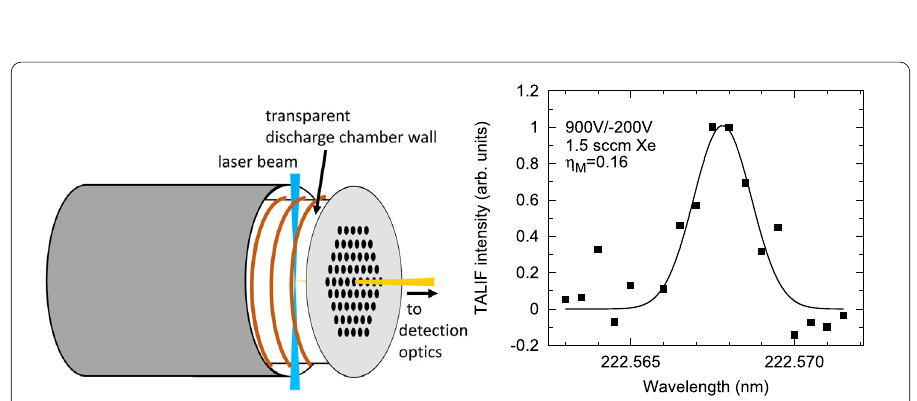
Figure 10 Left: Directions of excitation and fluorescence detection in a TALIF approach inside the discharge chamber of an ion source. Right: TALIF profile in the discharge chamber for the indicated operation condition